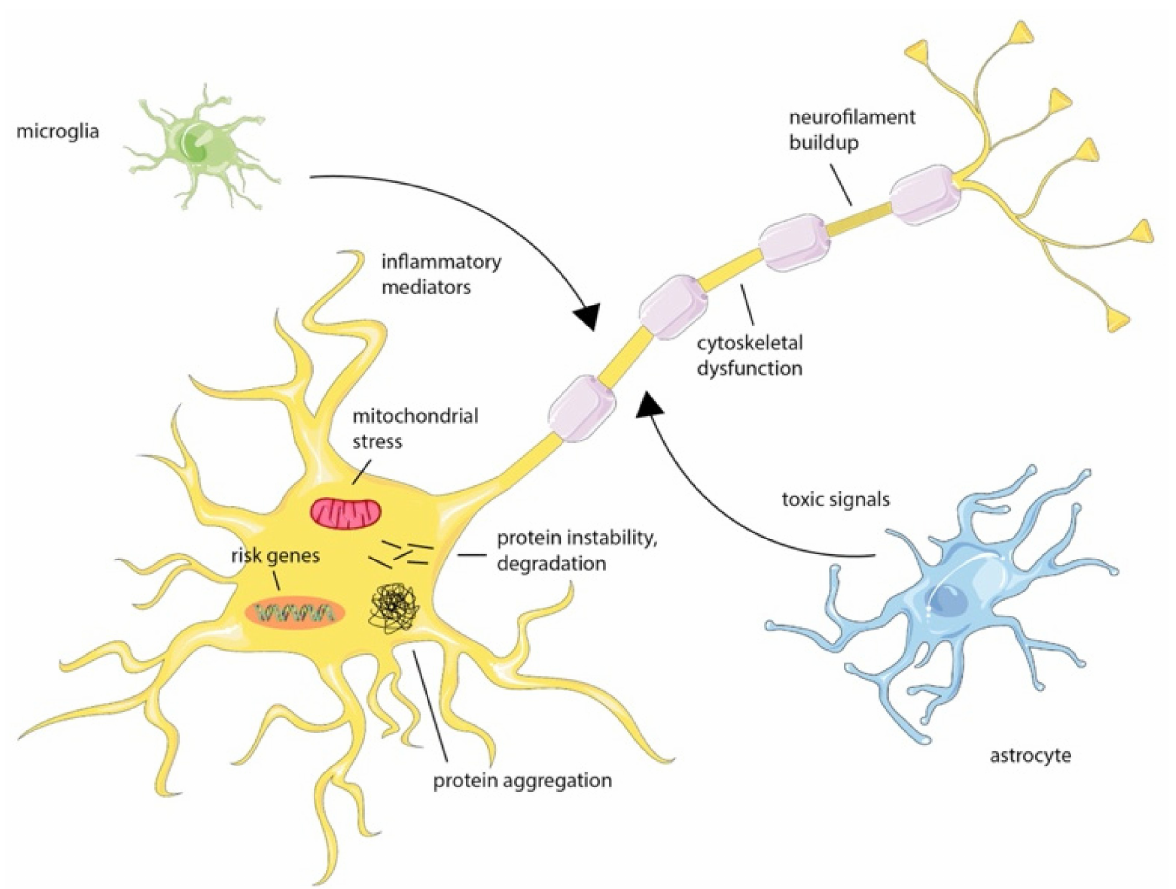
Figure 2. Cellular alterations of ALS. Molecular causes of ALS are still unknown, even if different cell types in the brain, such as microglia and astrocytes, are thought to contribute to neuronal dysfunction. The protein aggregation or degradation alters several pathways in the